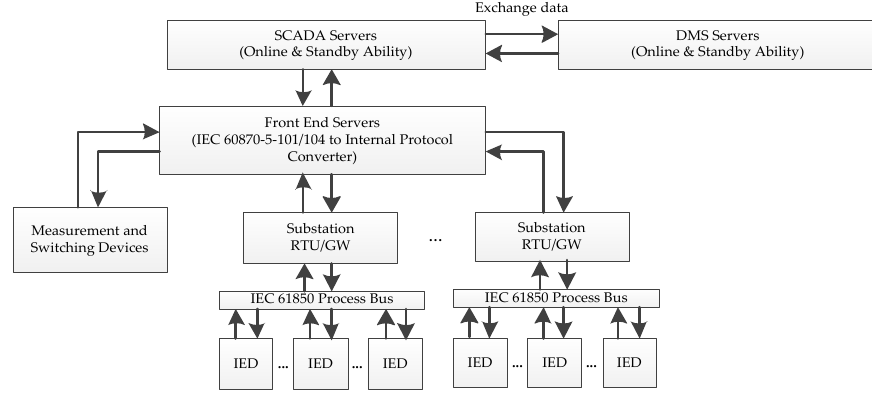
Figure 1. Centralized architecture of DMS for distribution network.